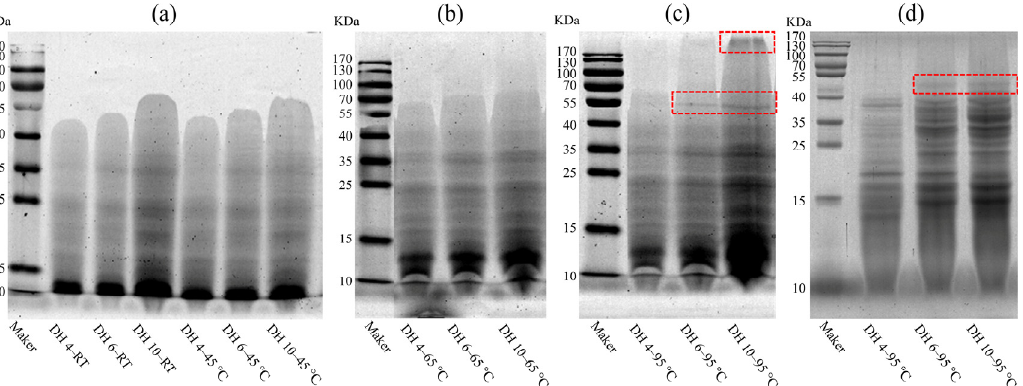
Figure 2. Electropherograms of GPs heated at 45 ( a ), 65 °C ( b ), 95 °C ( c ), and of reduced GPs ( d ). DH 4, DH 6, and DH 10 represent the degree of hydrolysis 4.0%, degree of hydrolysis 6.0%, and degree of hydrolysis 10.0%, respectively. The red boxes denote the different parts when heated at 95 °C.